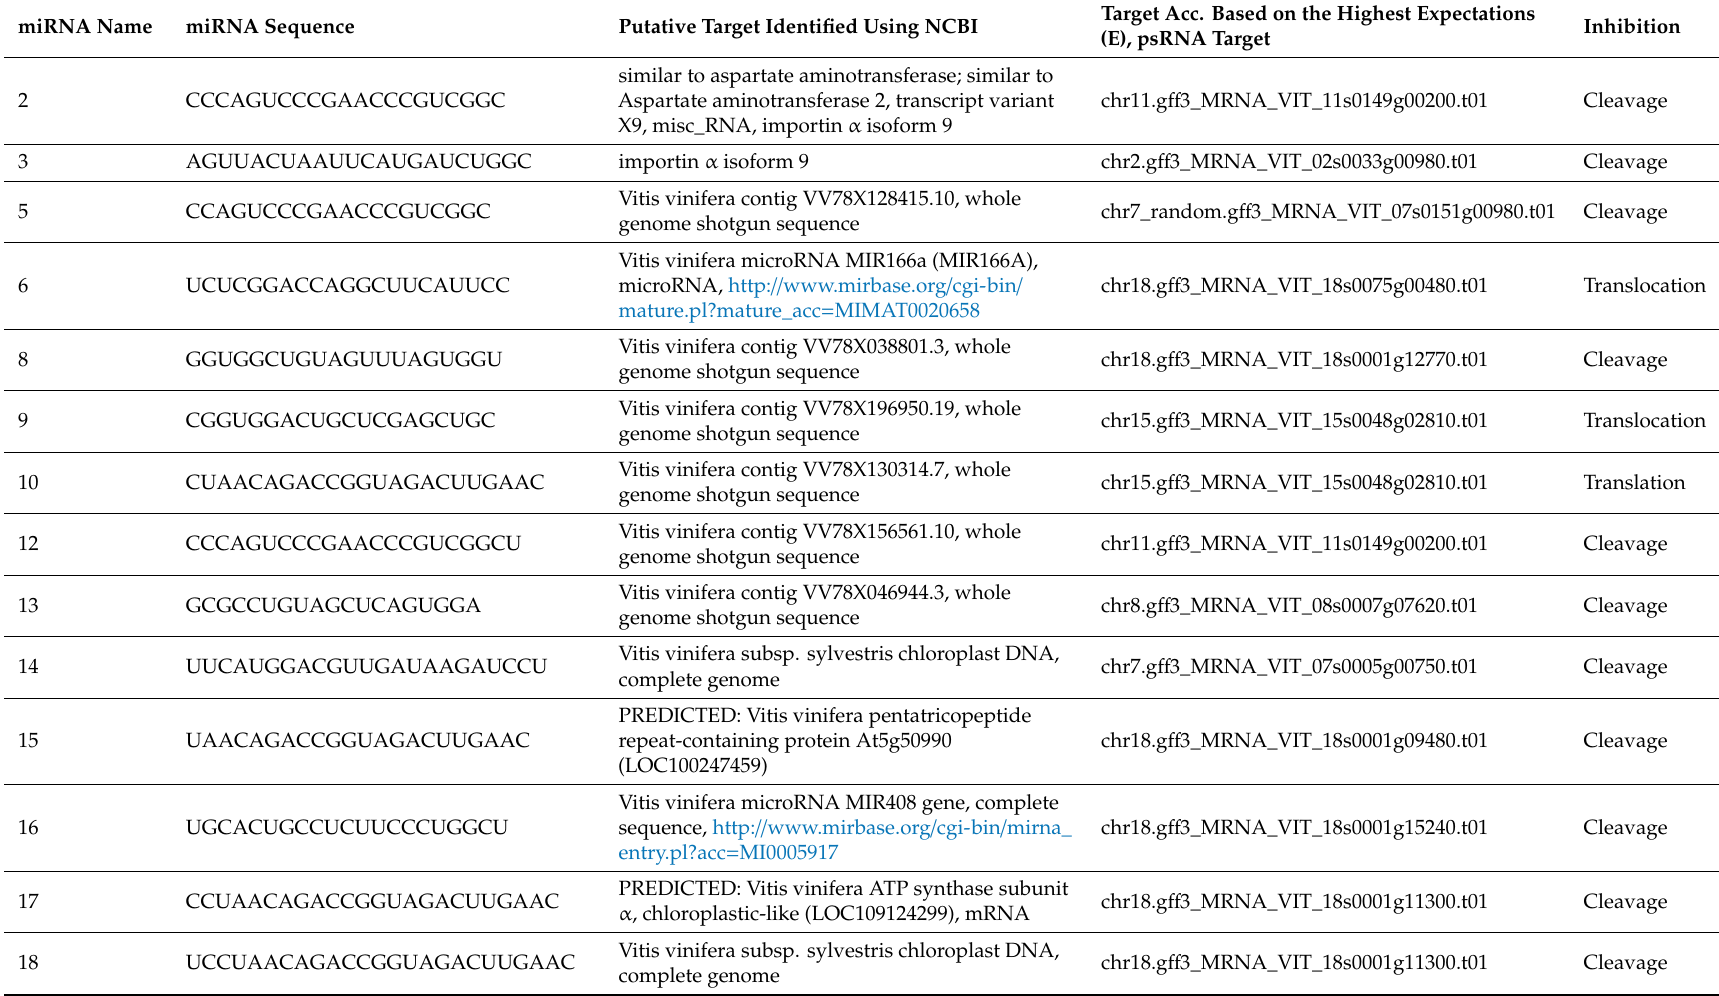
Table 2. Putative miRNAs identified using CLC Genomics WB 6.5.1, putative targets determined by blastN / NCBI and by psRNATarget with the possible type of